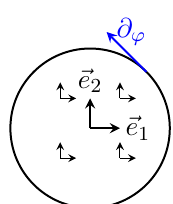
Figure 8. Local frame ( ~e 1 ;~e 2 ) relative to which the Dirac spinor is